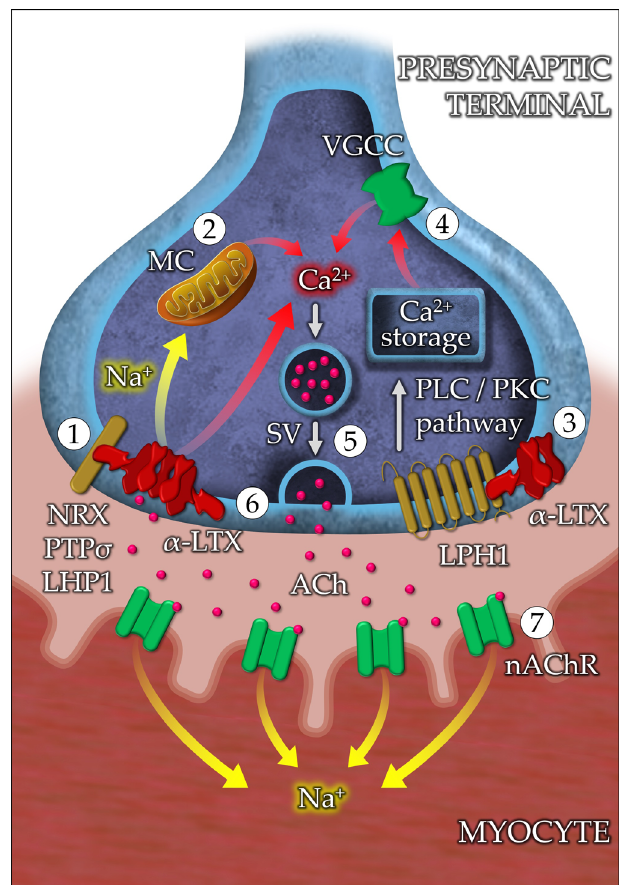
Figure 3. Proposed mechanisms of neurotoxicity of α-LTX in the neuromuscular junction. (1) In the presynaptic membrane, the wing region (N-terminal domain) of α-latrotoxin (α-LTX) interacts with neurexin-Iα (NXR-Iα), protein tyrosine phosphatase σ (PTPσ), and latrophilin 1 (LPH1). This interaction facilitates the insertion of the tetramer into the lipid bilayer, allowing the influx of monovalent (Li + , Cs + , Na + , K + ) and divalent (Ca 2+ , Ba 2+ , Mg 2+ ) alkali cations. (2) The excess of Na + induces the release of more Ca 2+ from the mitochondria into the cytoplasm. (3) α-LTX triggers LPH1 signaling, resulting in the activation of the phospholipase C (PLC)/ protein kinase C (PKC) pathway. PLC increases the levels of inositol trisphosphate, promoting the release of intracellular Ca 2+ stored in the endoplasmic reticulum. (4) The depolarization of the presynaptic terminal activates voltage-gated calcium channels (VGCC), allowing the influx of more Ca 2+ . (5) The massive increase in intracellular Ca 2+ promotes the mobilization of synaptic vessels (SV) containing the neurotransmitter acetylcholine (Ach). (6) The release of Ach into the synaptic cleft can be either due to the fusion of SVs with the plasma membrane or due to the leakage of the neurotransmitter through the α-LTX pore. (7) The interaction of Ach with the nicotinic acetylcholine receptor (nAChR) present in the membrane of the myocyte causes depolarization and muscle